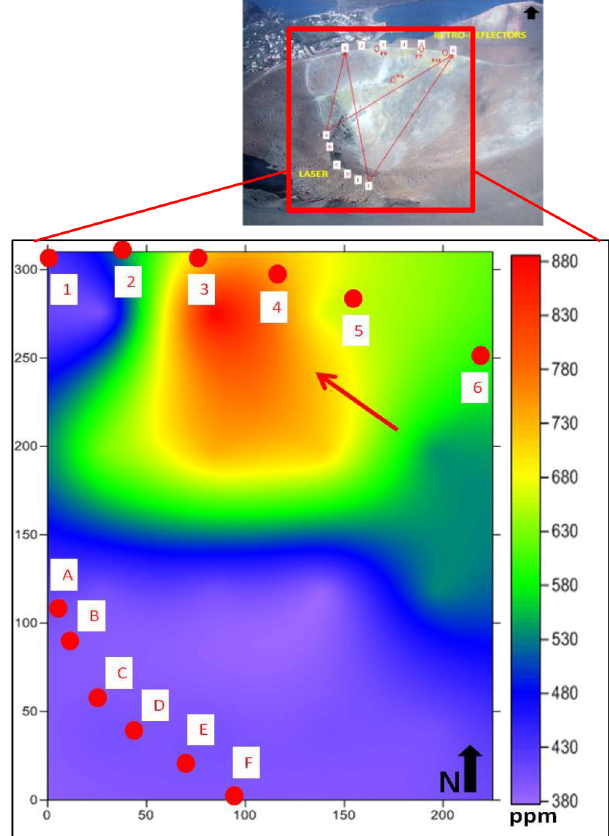
Figure 6. Contour map of CO 2 mixing ratios (ppm), La Fossa campaign, Vulcano Island, 11 March 2014. GasFinder and retro- reflectors positions are shown with letters and numbers, respec- tively. Red arrow: principal direction of plume